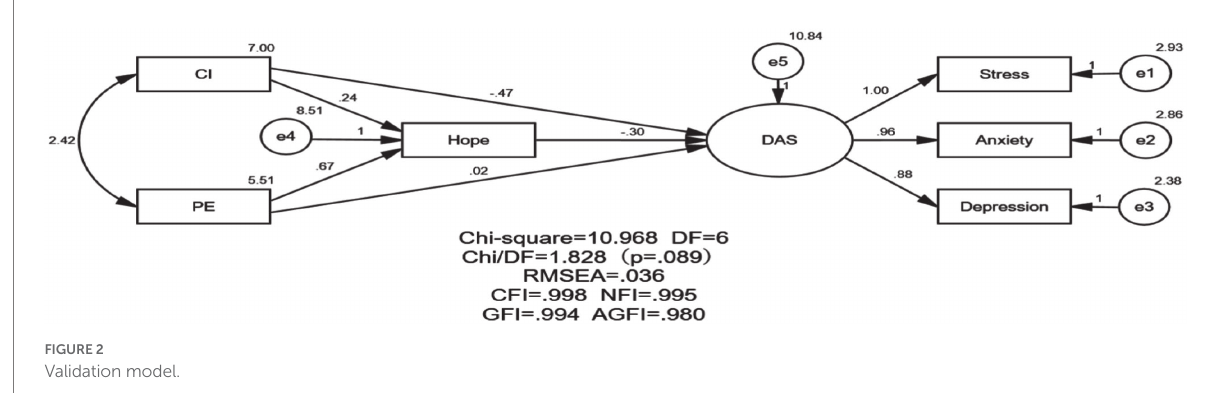
FIGURE 2 Validation model.